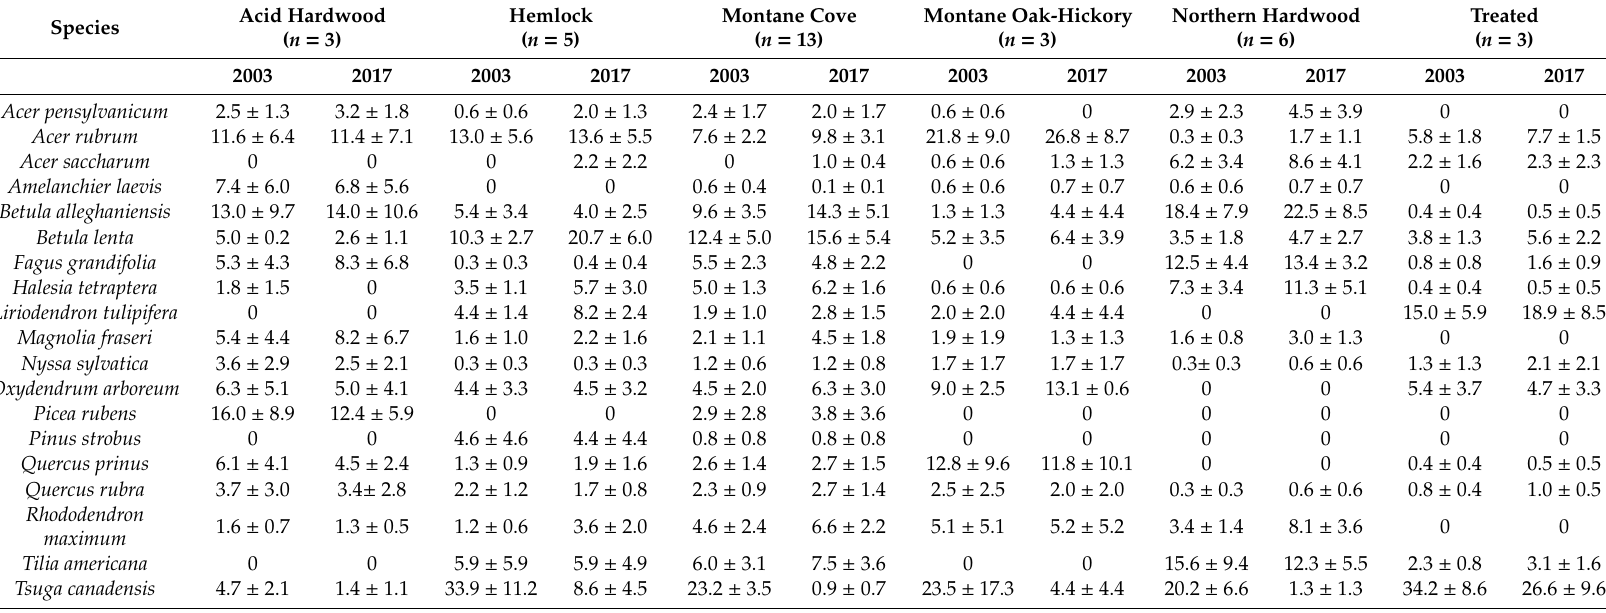
Table 2. Importance value (IV; mean ± SE) of selected species across ecogroups and chemically treated plots in 2003 and 2016 / 17 (shown as 2017). Only species with a mean IV greater than one calculated across all ecogroups and treated plots are